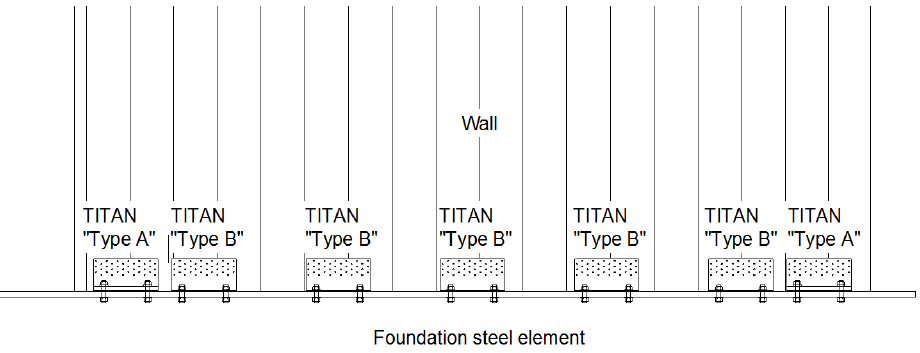
Figure 3. Wall B: Connections to steel foundation.